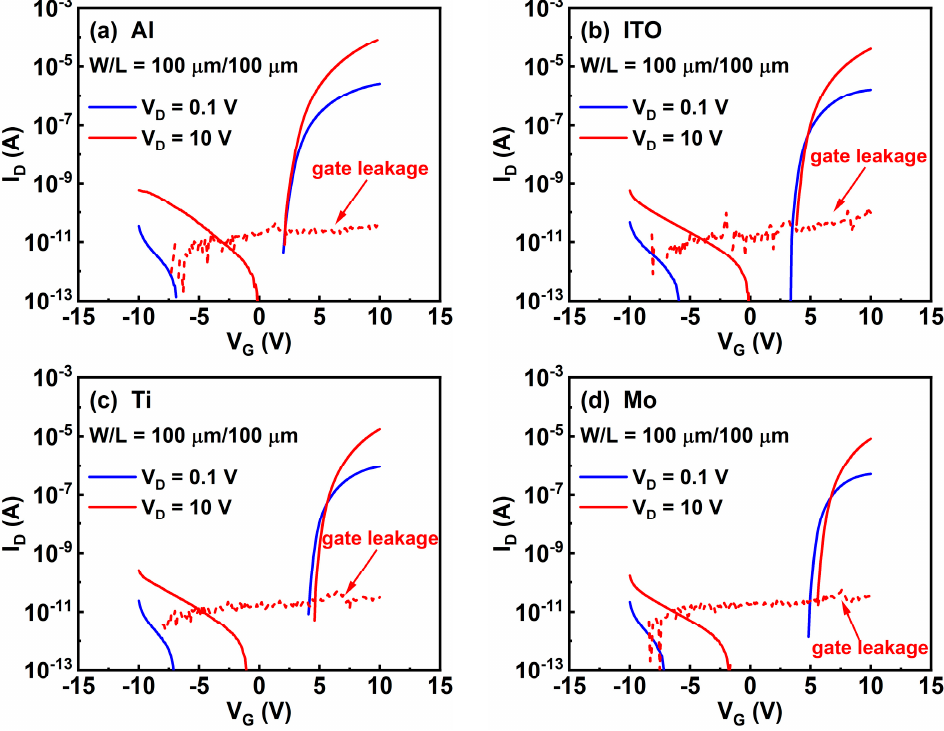
Figure 2. Transfer curves of annealed ITO TFTs with ( a ) Al, ( b ) ITO, ( c ) Ti, and ( d ) Mo source/drain electrodes.